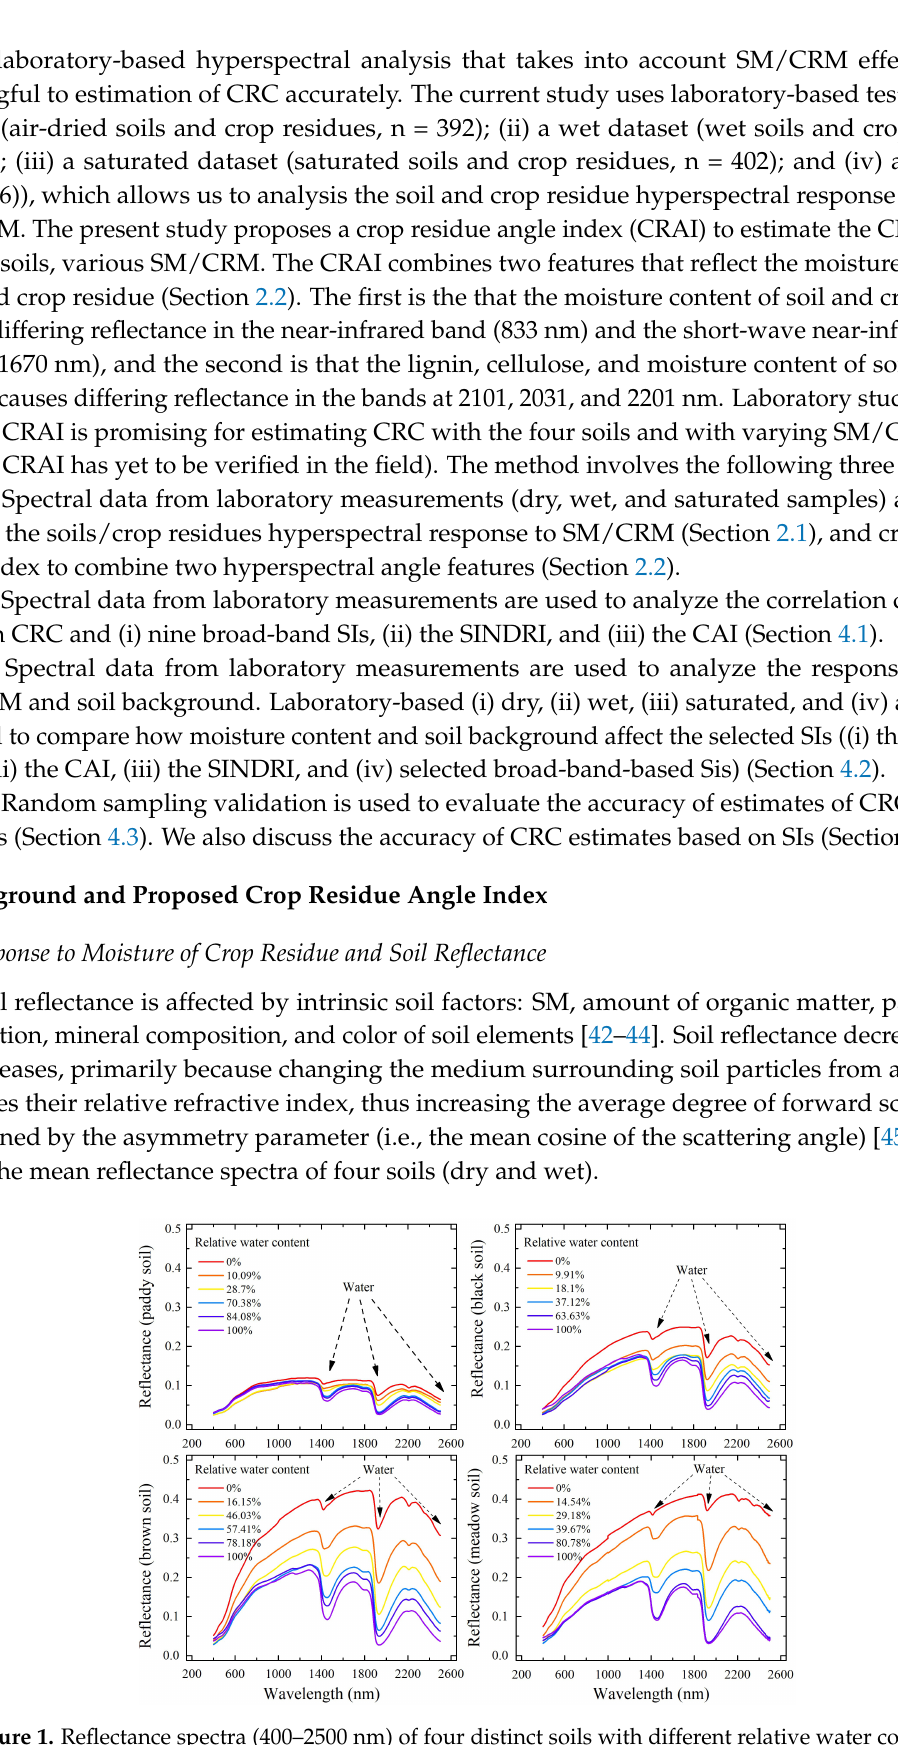
Figure 1. Reflectance spectra (400–2500 nm) of four distinct soils with different relative